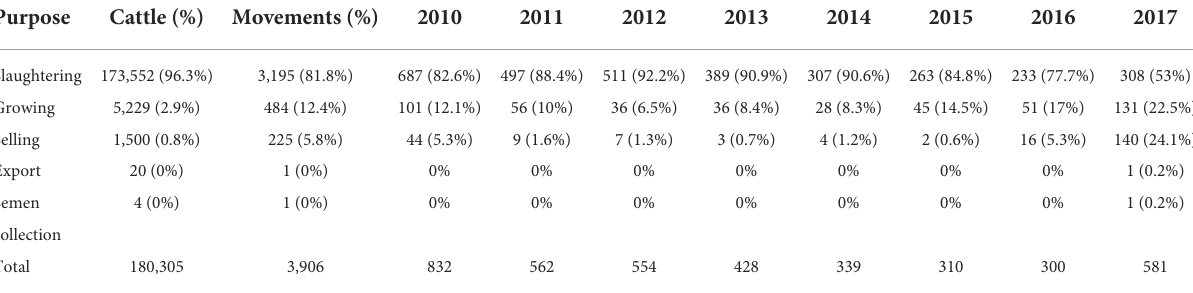
TABLE 4 Number of dairy cattle moved (animal head) and movements (frequency) between districts in northern Thailand for different primary purposes from 2010 to 2017.